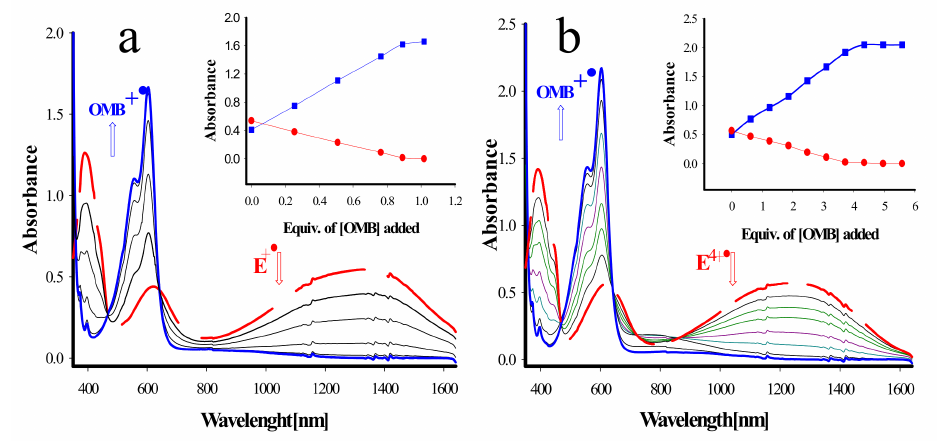
Figure 7. ( a ) Spectral changes upon the reduction of 1.89 × 10 − 4 M E + • (red dashed line)